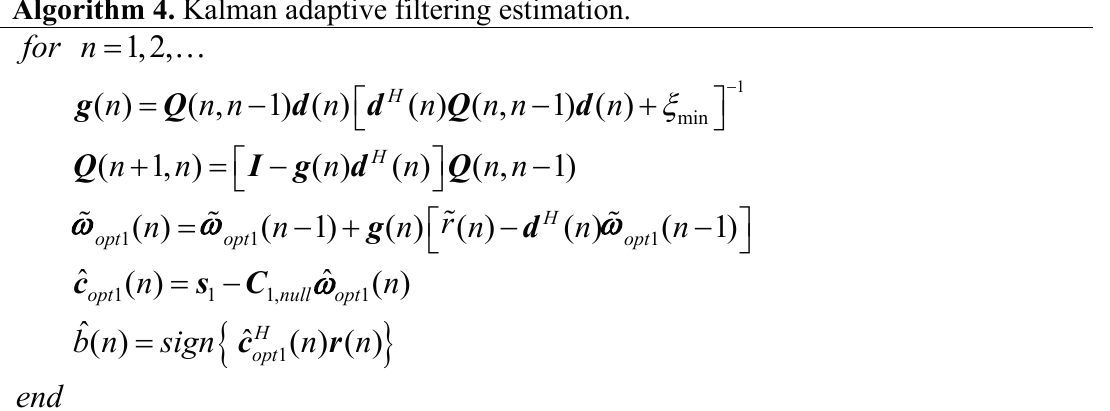
Algorithm 4. Kalman adaptive filtering